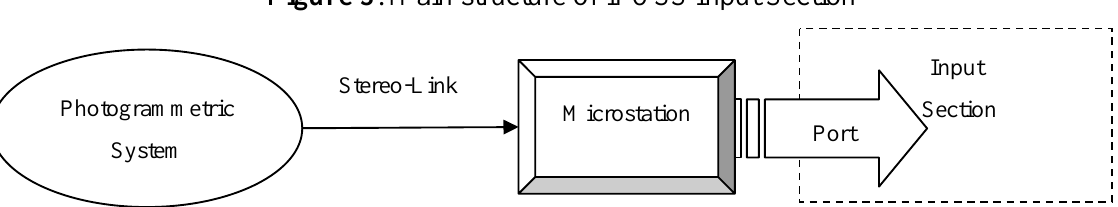
Figure 3 . Main structure of IPOSS Input